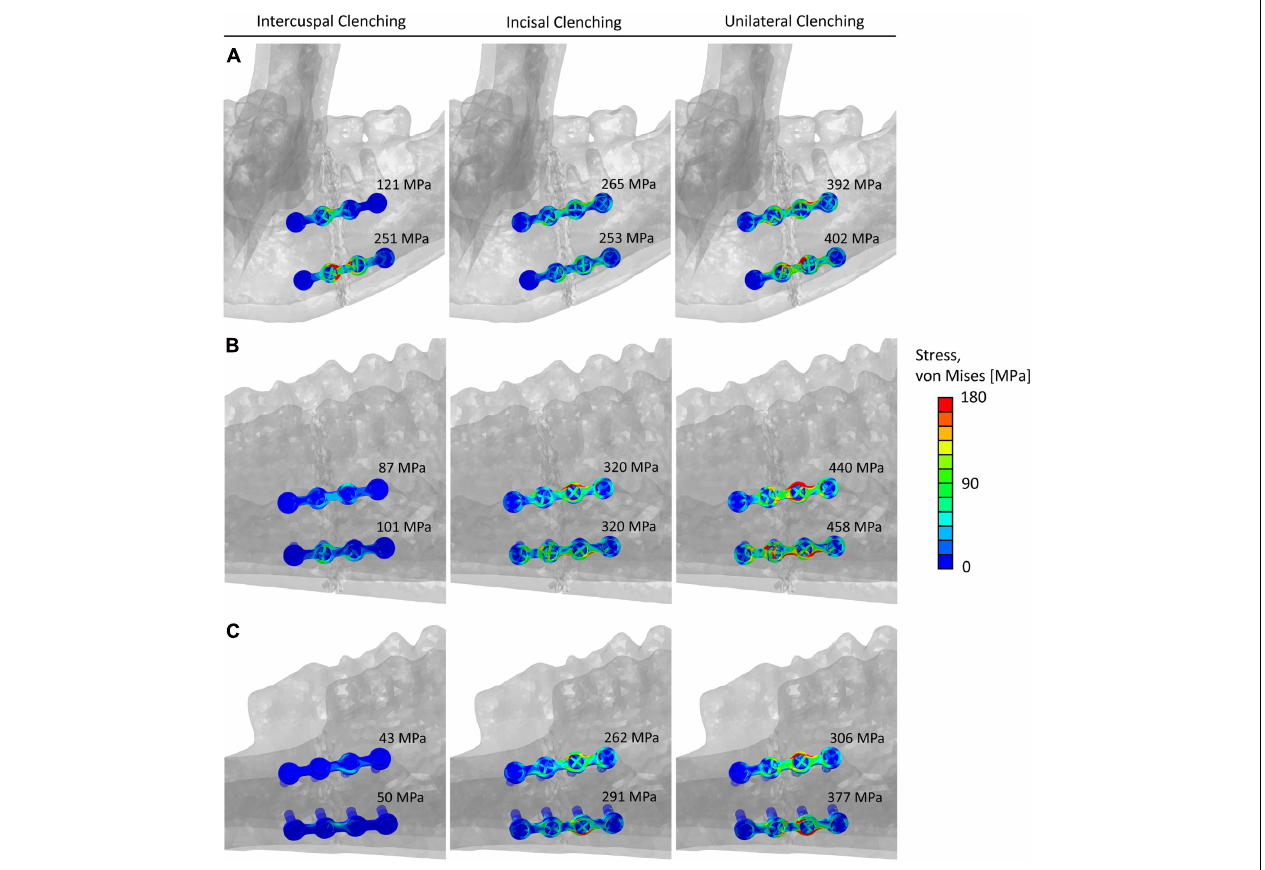
FIGURE 6 | Von Mises stresses distribution and peak values within the miniplates and screws in the (A) human mandibular body fracture, (B) sheep mandibular body fracture, and (C) sheep mandibular diastema fracture, for the intercuspal (ICP), incisal (INC), and unilateral (UNI) clenching